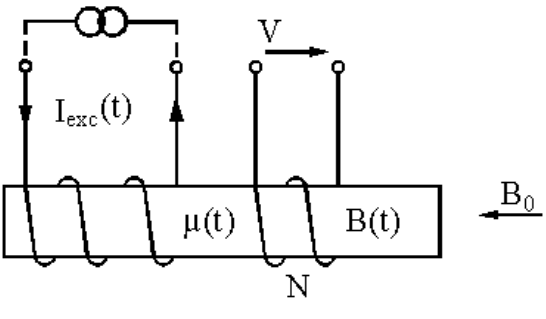
Figure 7. Magnetometer sensor with single core [20].